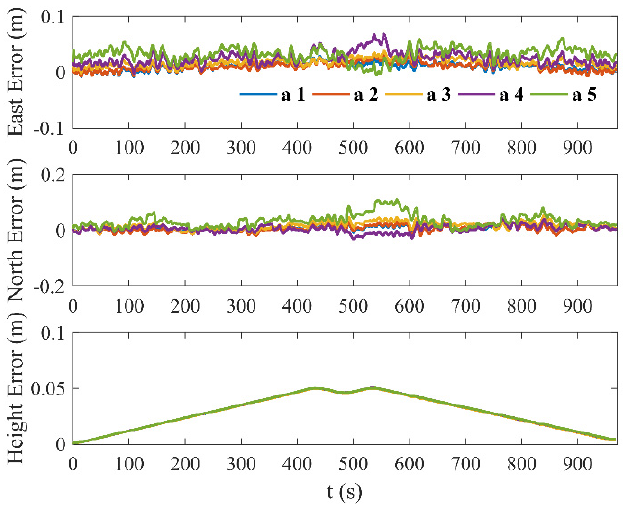
Figure 12. Positioning errors under different feature distributions.